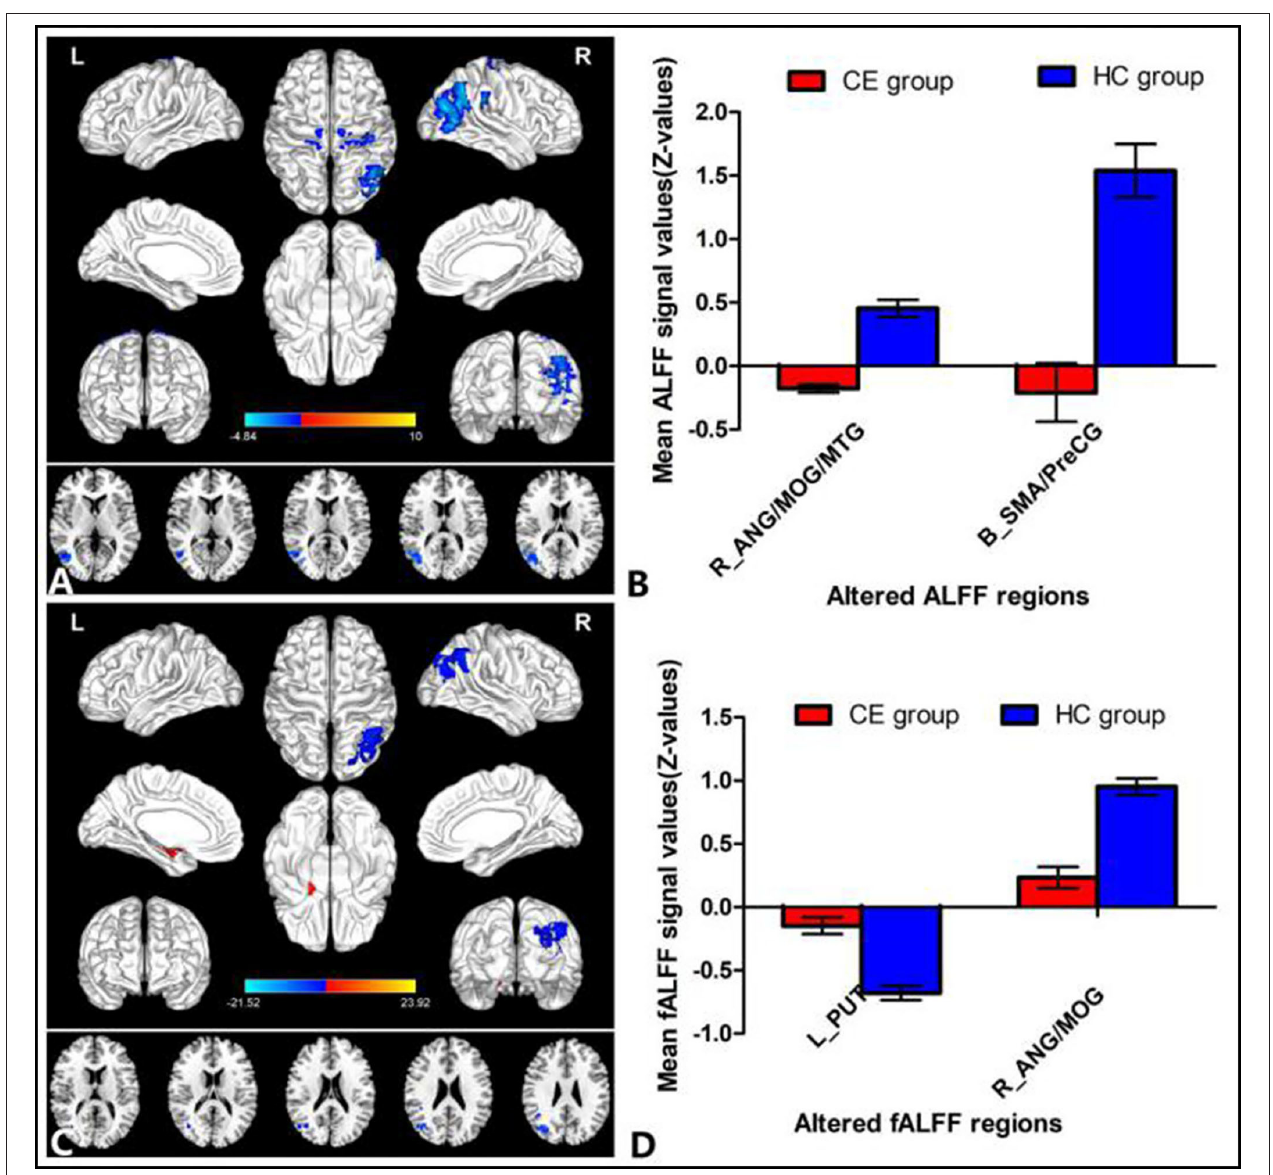
FIGURE 2 | Group comparisons of the ALFF and fALFF between the CE and HCs. Significantly different ALFF was found between the two groups. (A) Significantly different fALFF were found between the two groups. (C) The blue areas denote lower ALFF and fALFF values, and the red areas denote increased ALFF and fALFF values. The mean values of altered ALFF/fALFF values are shown in a histogram (B,D) . ALFF, amplitude of low-frequency fluctuation; fALFF, fractional amplitude of low-frequency fluctuation; CE, comitant exotropia; HC, healthy control; ANG, angular; MOG, middle occipital gyrus; MTG, middle temporal gyrus; SMA, supplementary motor area; PreCG, precentral gyrus; PUT, putamen; R, right; L, left.